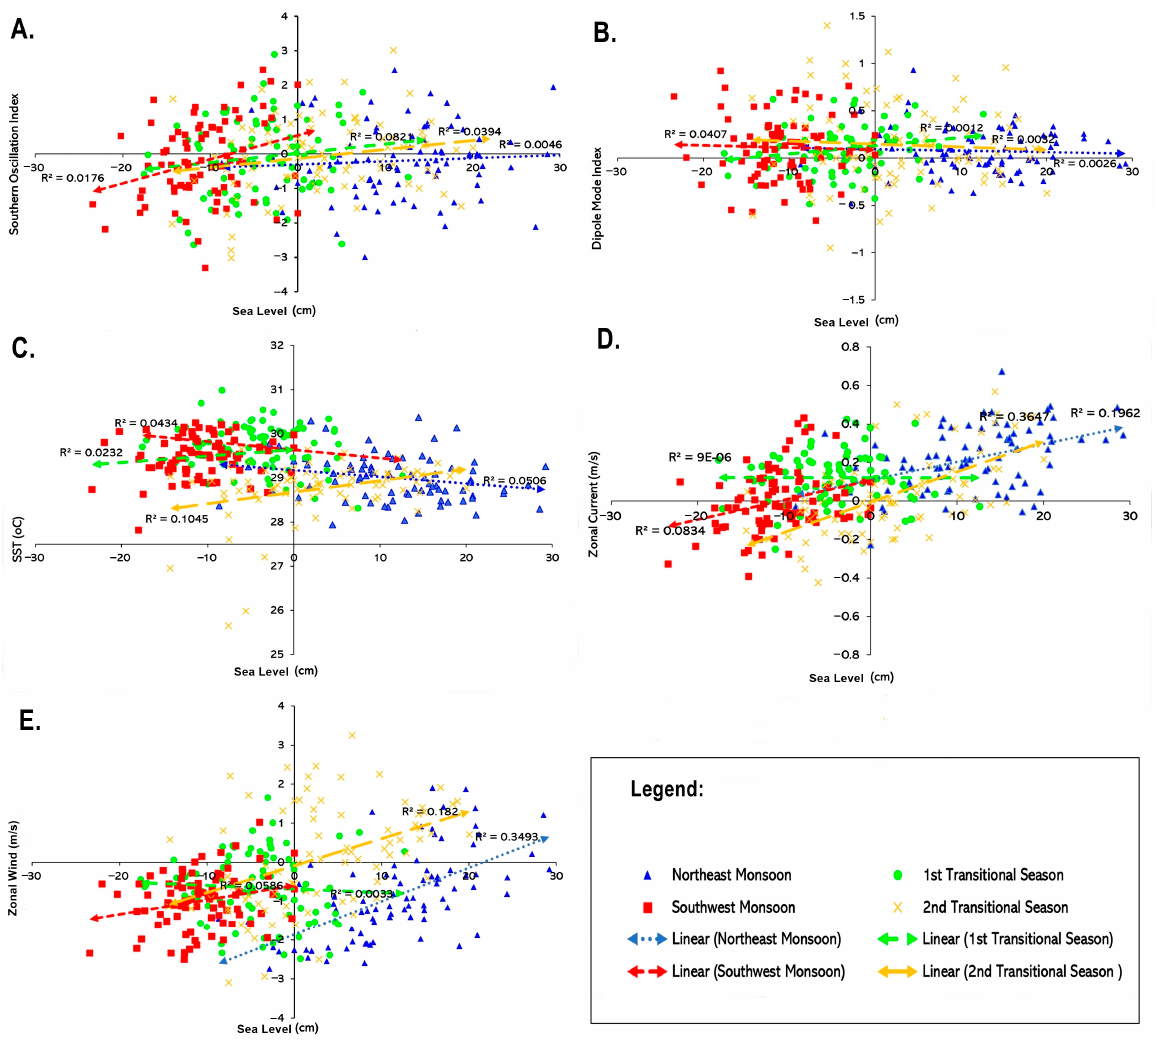
Figure 4. Intra-seasonal correlation analysis of sea level vs. SOI ( A ), sea level vs. DMI ( B ), sea level vs. SST ( C ), sea level vs. zonal currents ( D ), and sea level vs. zonal winds ( E ).